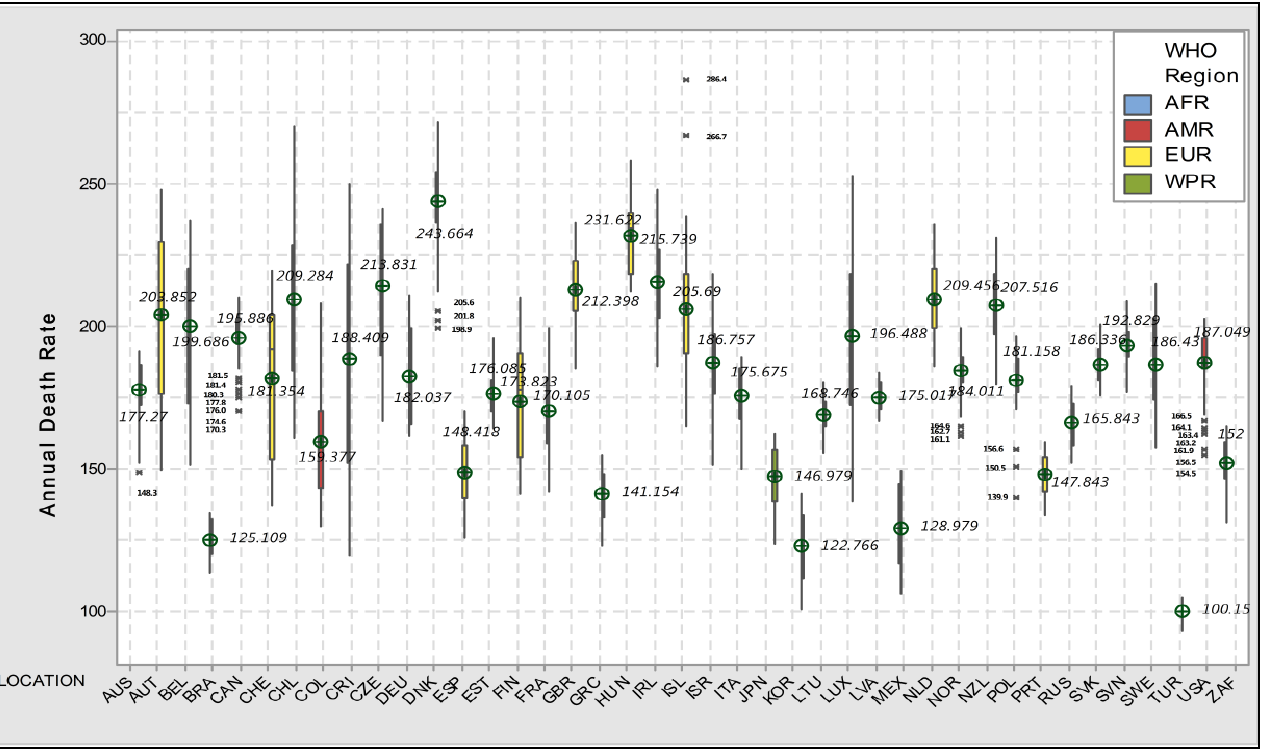
Figure 2 : Dataset segregation, based on WHO geographical distribution by countries shown as Box plot, indicating the means, data spreading and the aberrant annual mortality rates records generated using Minitab